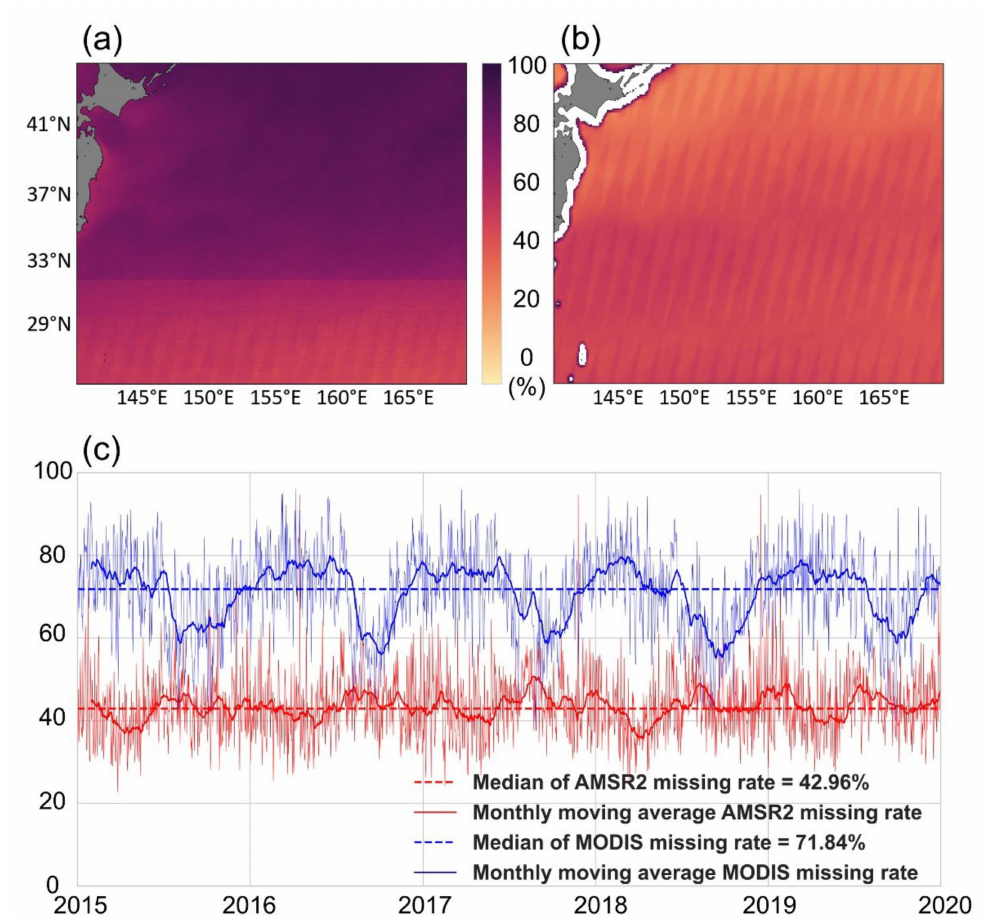
Figure 2. ( a ) Spatial distribution of the average missing percentage of the AMSR2 SST data for the five years. ( b ) Spatial distribution of the average missing percentage of the MODIS SST data for the five years. ( c ) Temporal variation of daily and 30 day-moving average missing percentage of AMSR2 and MODIS SSTs for the study